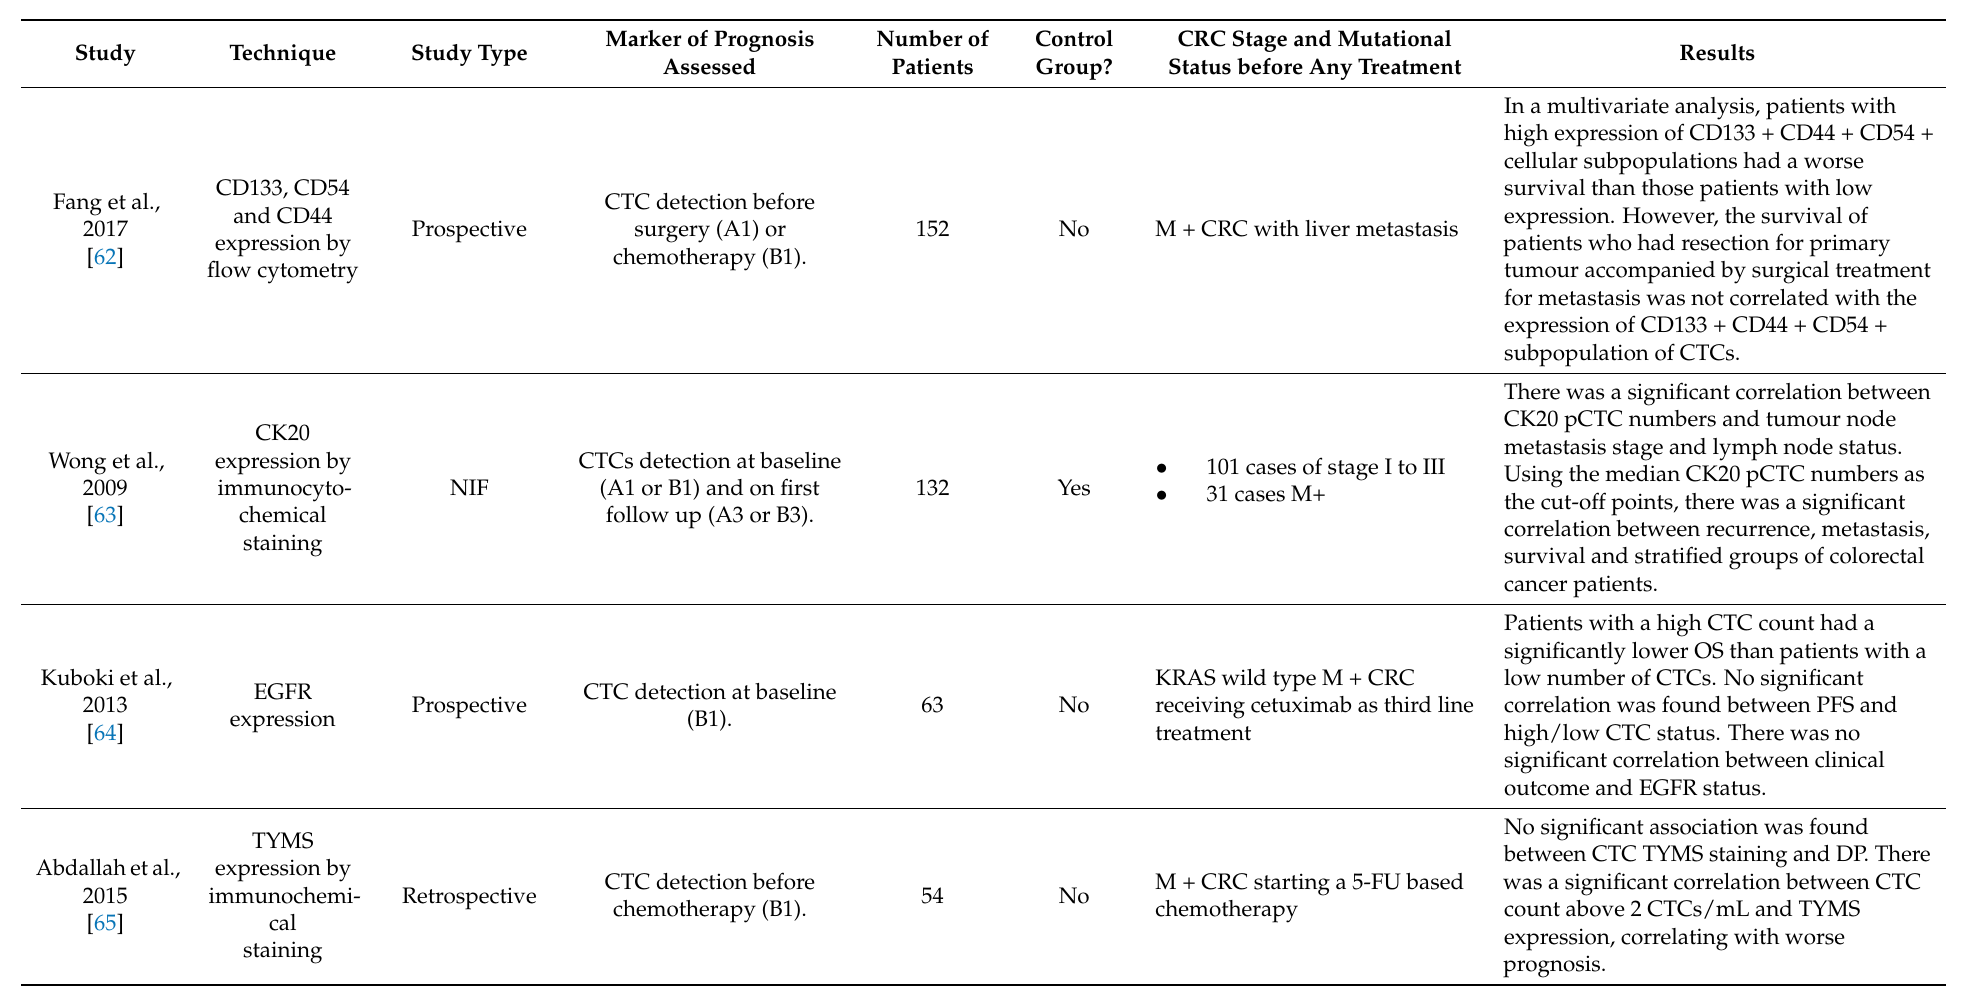
There was a significant correlation between CK20 pCTC numbers and tumour node metastasis stage and lymph node status. Using the median CK20 pCTC numbers as 31 cases M+ the cut-off points, there was a significant correlation between recurrence, metastasis, survival and stratified groups of colorectal cancer patients. Patients with a high CTC count had a significantly lower OS than patients with a low number of CTCs. No significant correlation was found between PFS and high/low CTC status. There was no significant correlation between clinical outcome and EGFR status. between CTC TYMS staining and DP. There